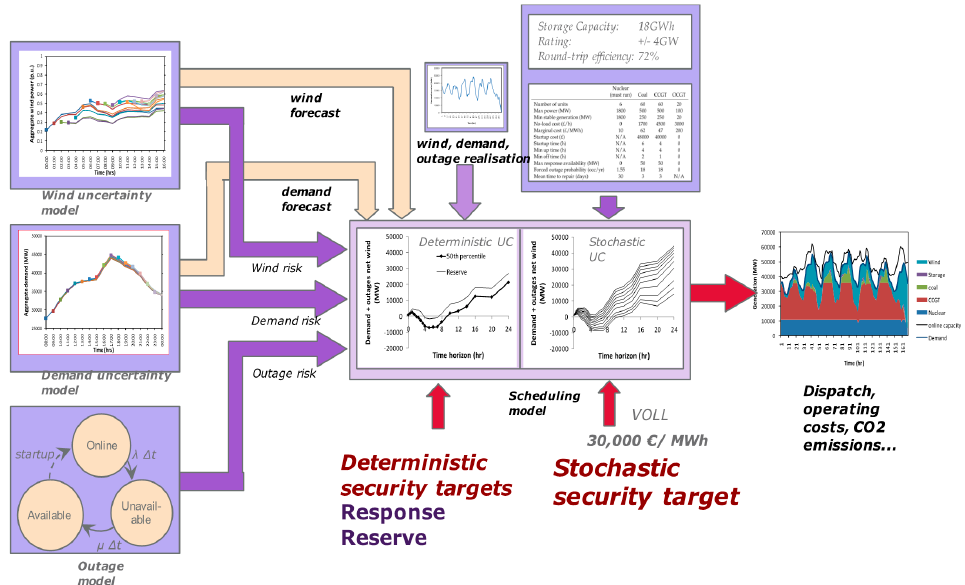
Figure 3. Structure of the Advanced Stochastic Unit Commitment (ASUC).